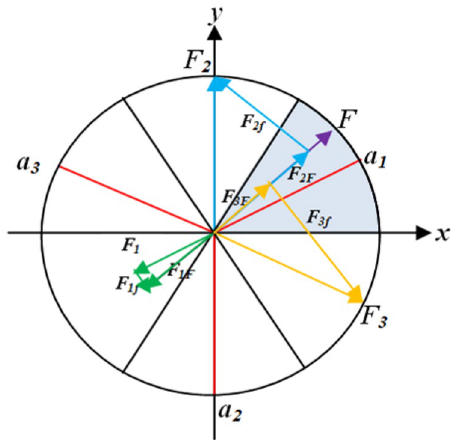
Fig. 12 Steering and pad forces when 90 < α